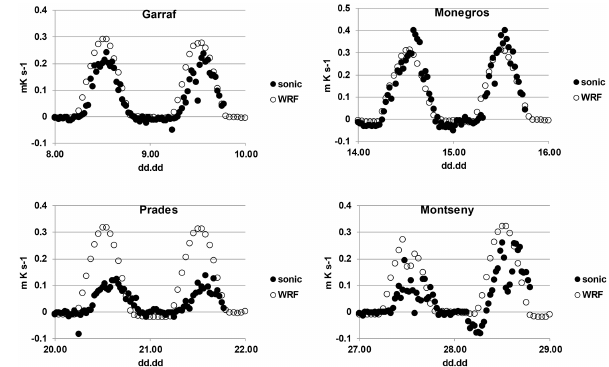
Figure 1. Boundary layer heights (m) computed by the WRF model for the days of sampling at the four landscapes studied. Figure 2. Comparison of the sensible heat flux (mdegKs